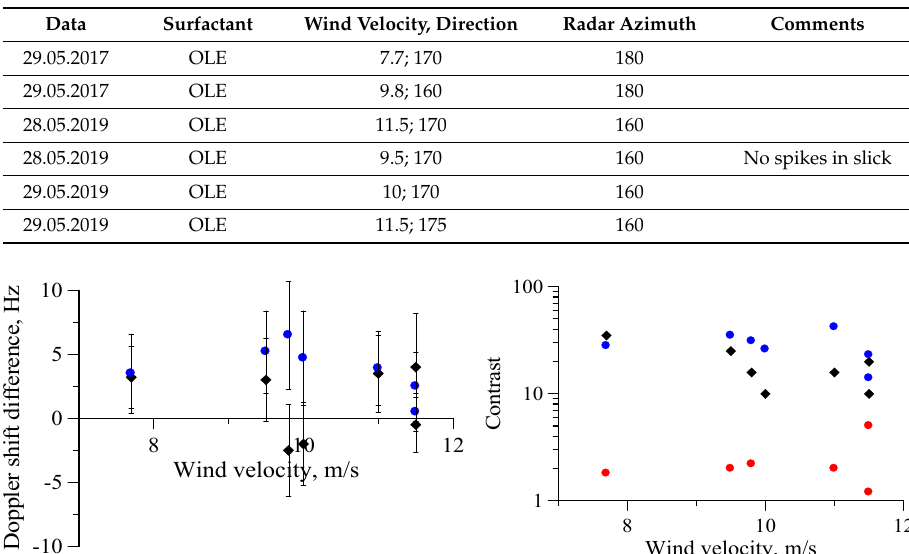
Table 1. Observation of film slicks.